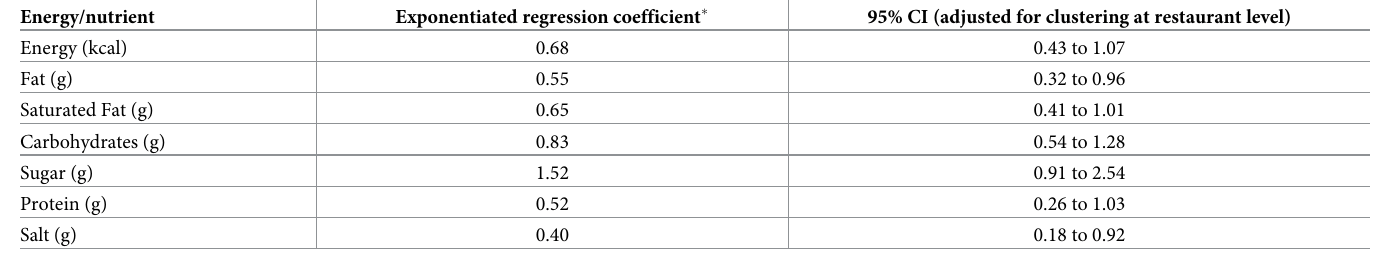
Table 5. Summary of linear regression models comparing log transformed energy and nutritional content of 9605 menu items from 42 popular UK restaurants with and without voluntary menu